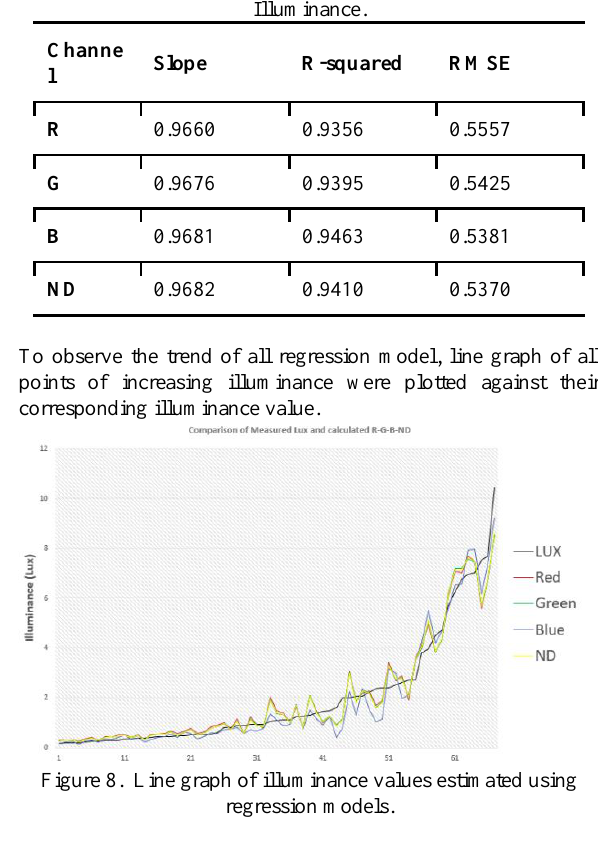
Table 3. Statistics of Calculated Illuminance vs. Measured